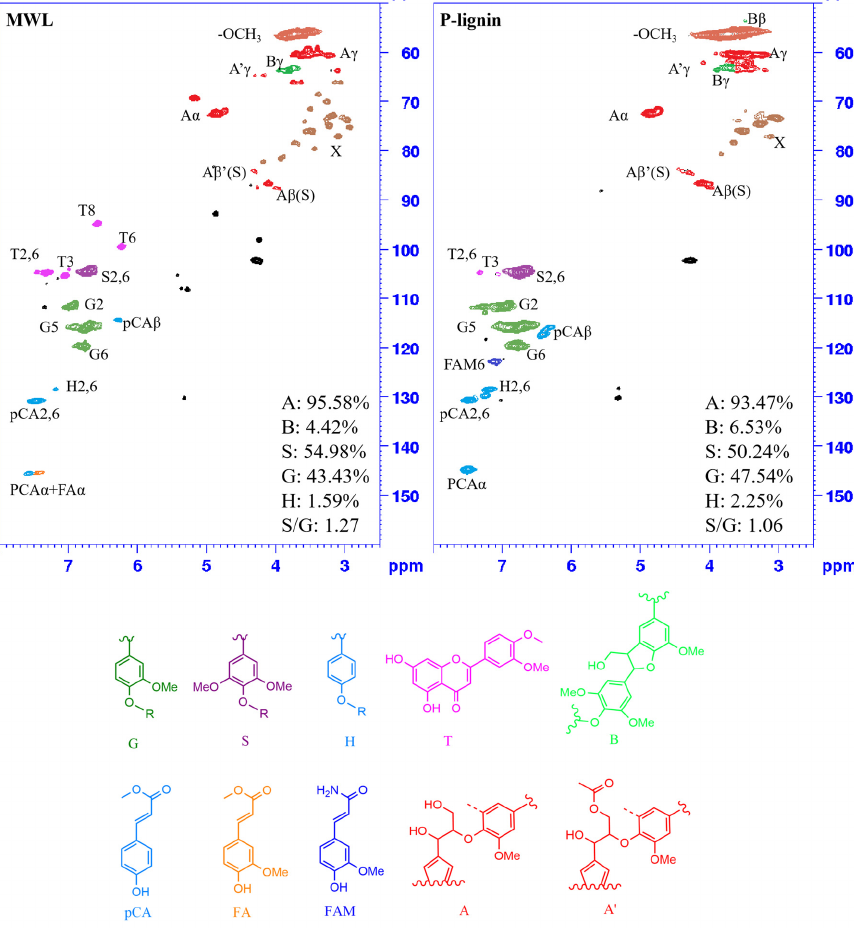
Figure 7. Two-dimensional HSQC NMR spectra of MWL and P-lignin (extracted at optimal pretreat- ment conditions). Signals are depicted in Table